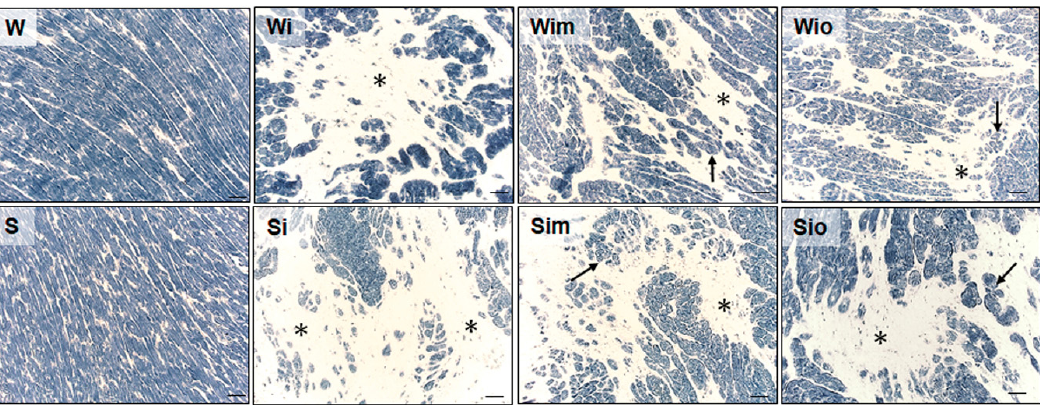
Figure 4. Reliable histochemical demonstration of SDH activity revealed its absence in necrotic cardiomyocytes (asterisks) and reduced activity in surrounding atrophied myocytes in ISO-exposed Wistar (Wi) and Spontaneously hypertensive rat (Si) hearts. Note apparent preservation of SDH activity in viable cardiomyocytes (arrows) and reduced areas of injury (asterisks) in ISO-exposed rats after treatment with melatonin (Wim, Sim) or omega-3 (Wio, Sio). The intensity of staining in controls (W, S) corresponds to normal SDH activity. Bar 200 µm.